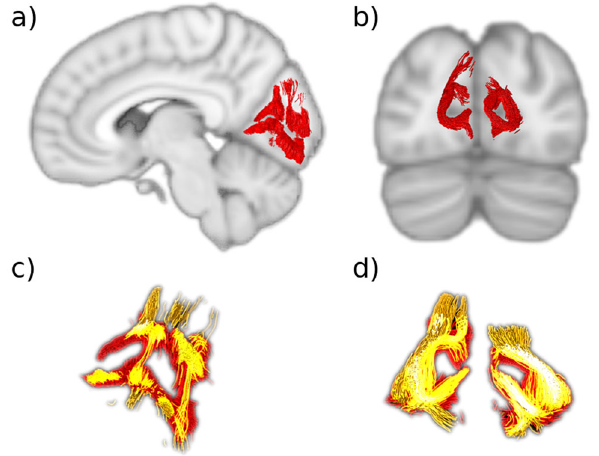
Fig. 2 The stratum calcarinum (SC). a Sagittal slice showing the right SC (red) curved around the calcarine fi ssure. b Coronal slice showing the left and right SC. c , d The two layers of the SC. The deeper and longer layer (orange) lies under the more super fi cial and u-shaped layer (red). Where they intersect is shown in bright